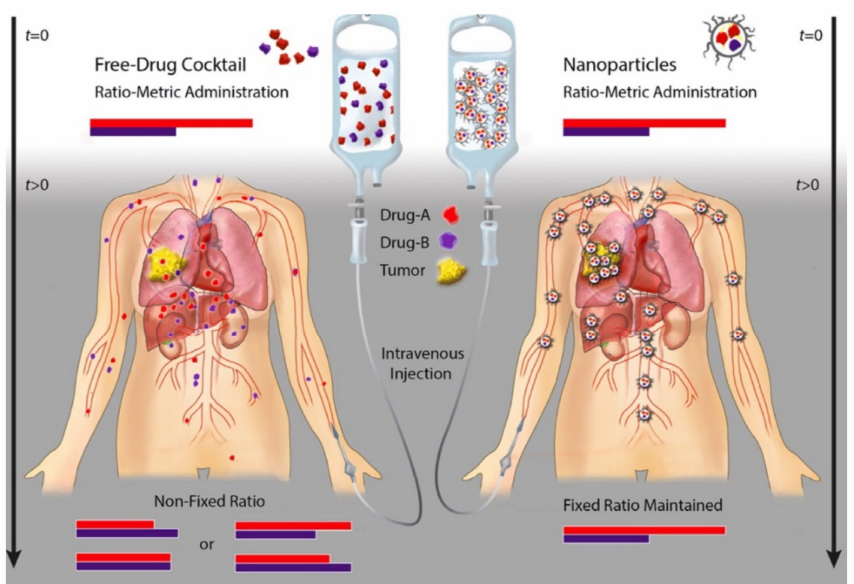
Figure 2. Ratiometric drug delivery of combinatorial drugs using nanoparticles is more advantageous in terms of pharmacokinetics and biodistribution of drug combinations compared to free combinatorial drugs. Reproduced with permission from [40], Journal of Controlled Release,